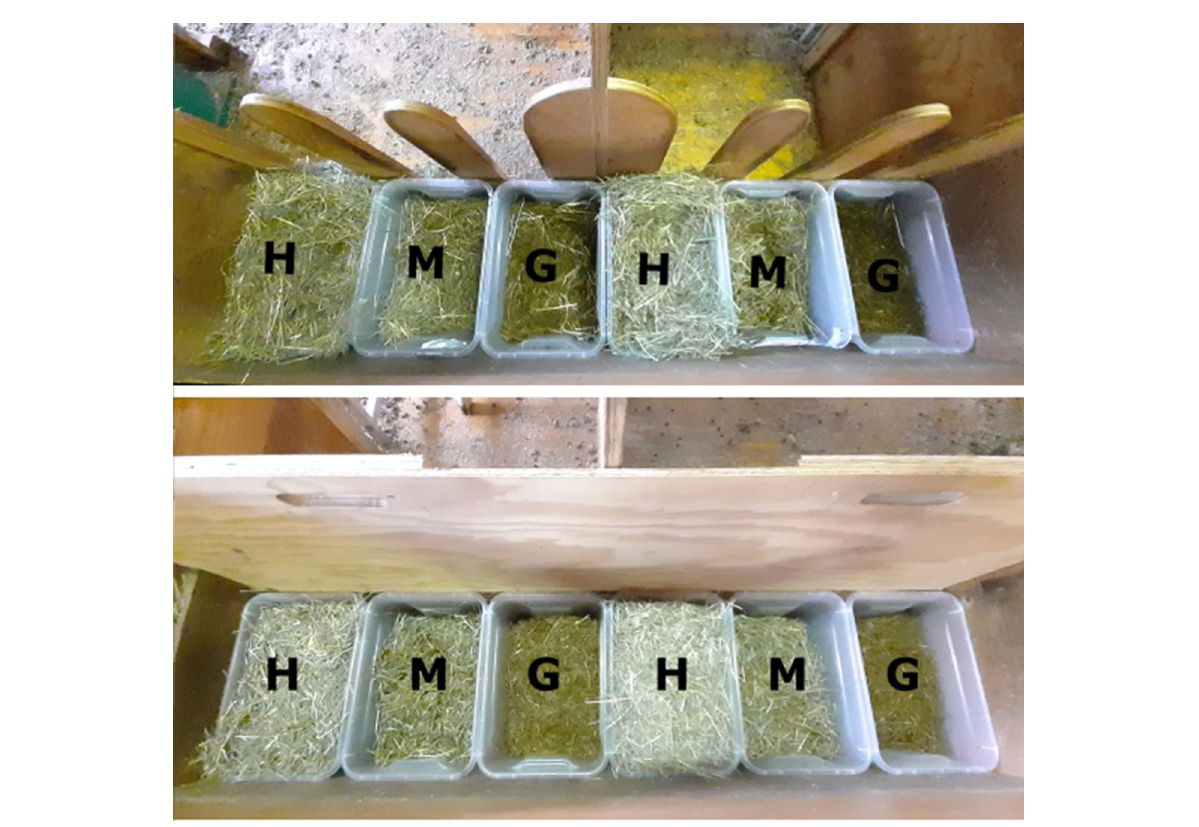
FIGURE1 Top view of the feeding trough in the experimental pen (for sheep or goat pairs) with three plastic feed containers per feeding place filled with either grass silage (G), hay (H), or the hay-grass silage mixed ration (M). (Top) the animals have access to the feed. (Bottom) access to the feed is blocked while the containers are weighed and to measure the animals’ first choice after access is